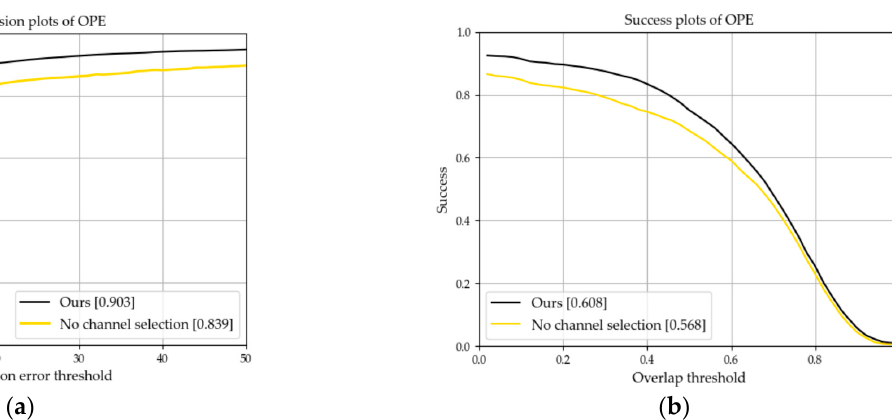
Figure 5. Response of different feature extractors. ( a ) Original image; ( b ) Response of HOG; ( c ) Response of BHOG + SSHMG. In the figure, the red rectangular area is the search range of the tracker for the target at the current time, i.e., the background area. The black rectangle represents the location of the target predicted by the tracker, which is the target area. Within the predicted box, the closer the pixel is to green, the more likely it is to belong to the target. When the color difference between the background area and the target area is large, it indicates that the tracker is robust in tracking the targets.